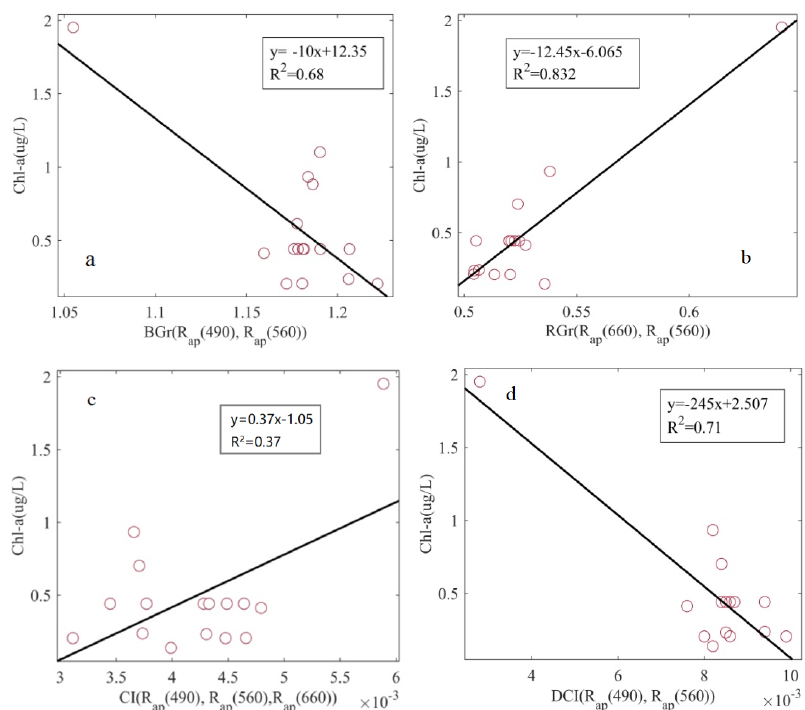
Figure 8. Scatterplots of the Chl-a concentration as a function of ( a ) BGr calculated by R ap (490) and R ap (560); ( b ) RGr calculated by R ap (560) and R ap (660); ( c ) color index (CI) calculated by R ap (490), R ap (560), and R ap (660); and ( d ) DCI calculated by R ap (490) and R ap (560).